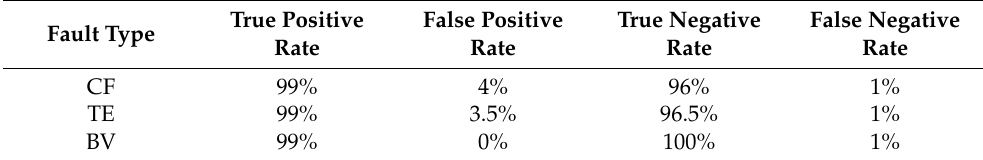
Figure 17. Predicted value of P3 vs. actual value. Table 4. Diagnostics system accuracy for fleet